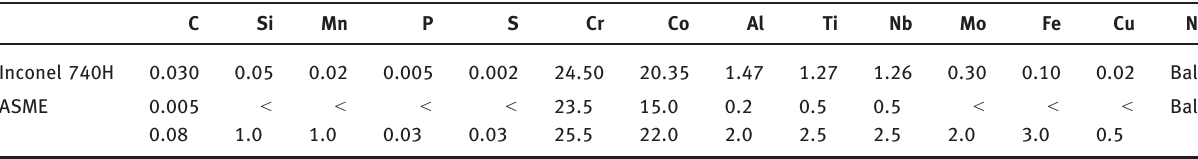
Table 1: Composition of Inconel 740H used in the present study (mass